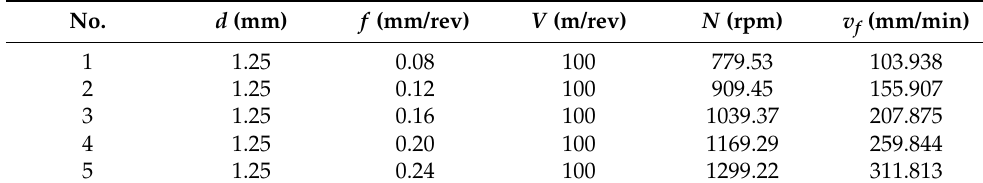
Table 4. Machining parameters used for the tool feed rate variation tests.